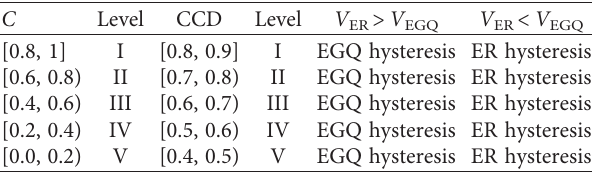
Table 2: CCD evaluation